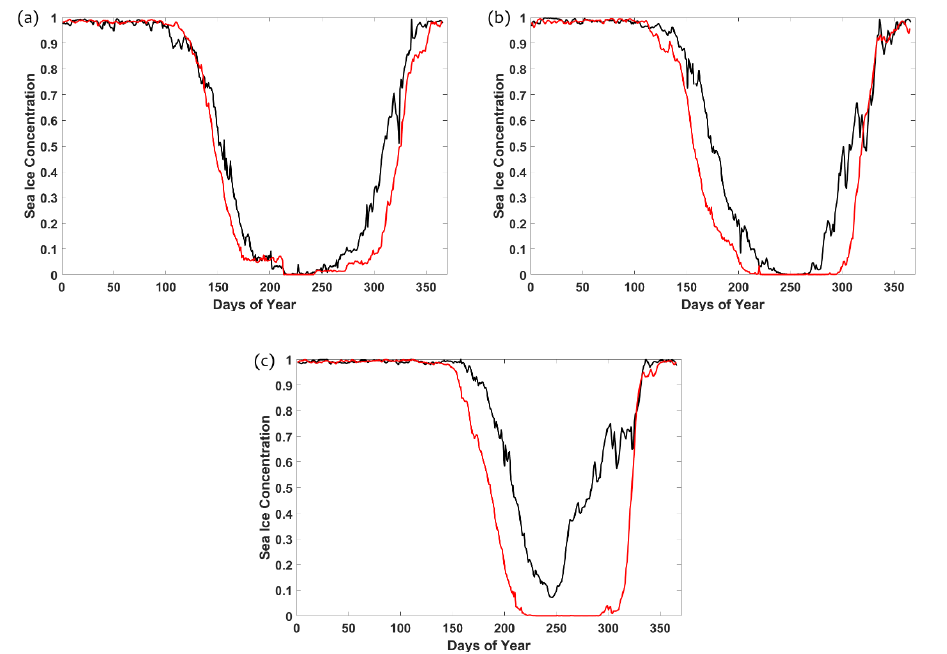
Figure 8. Daily evolutions of the area-averaged ice cover in ( a ) southern, ( b ) central and ( c ) northern Chukchi Sea; black curves represent multi-year mean data from the pre-1997 period, while red contours represent the post-1997